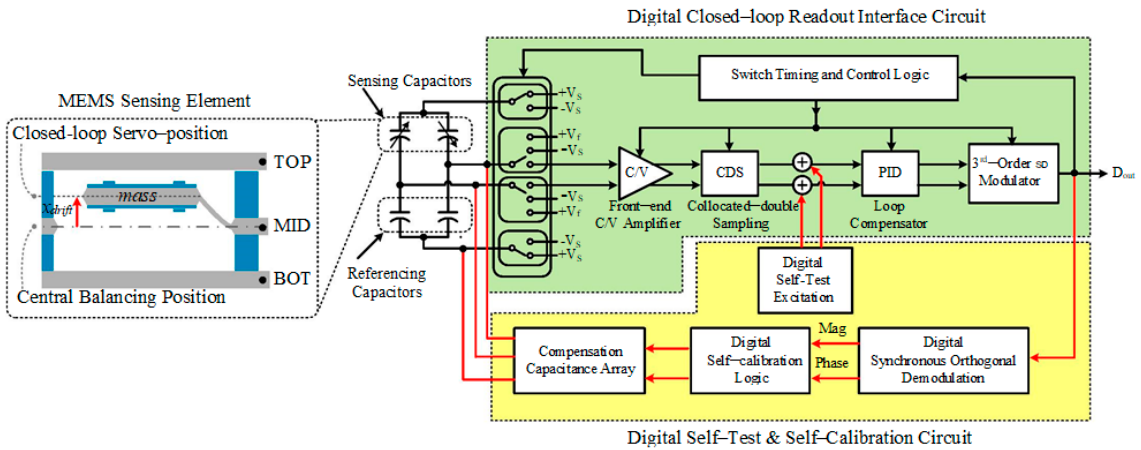
Figure 1. The system architecture of the proposed digital closed-loop readout interface circuit and digital self-test and self-calibration circuit.